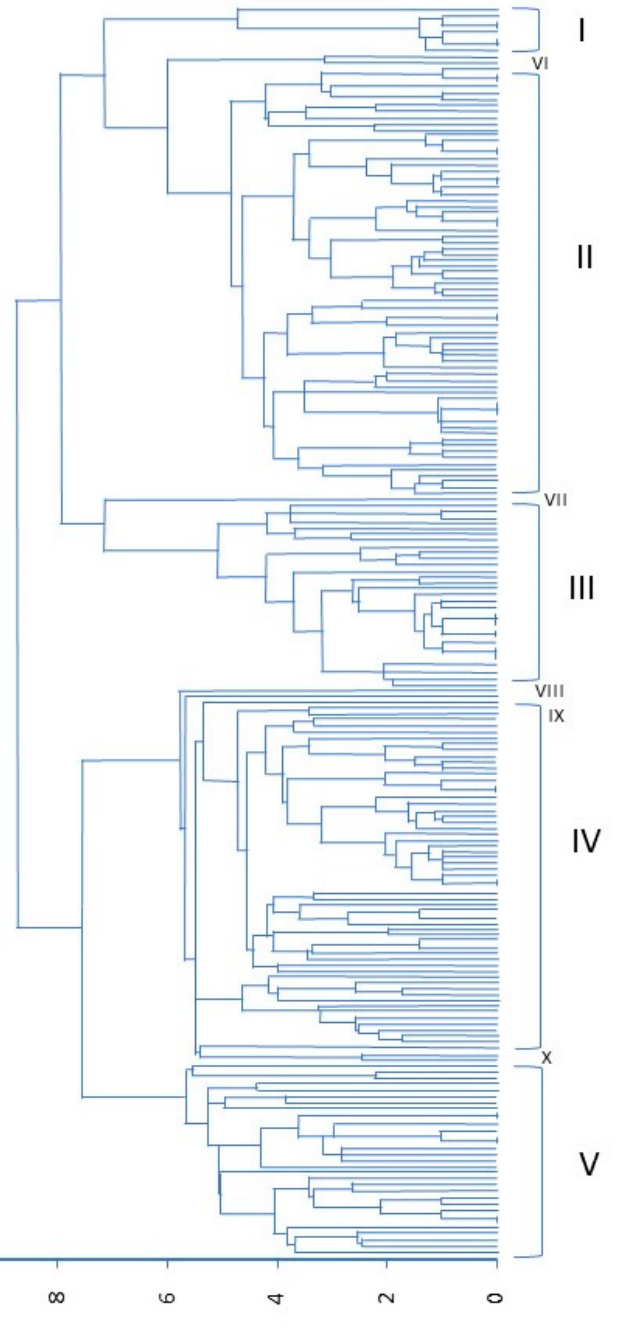
Figure 2. UPMGA (unweighted paired group method using arithmetic mean) dendrogram showing hierarchical grouping patterns of 260 Amaranths accessions from USDA.